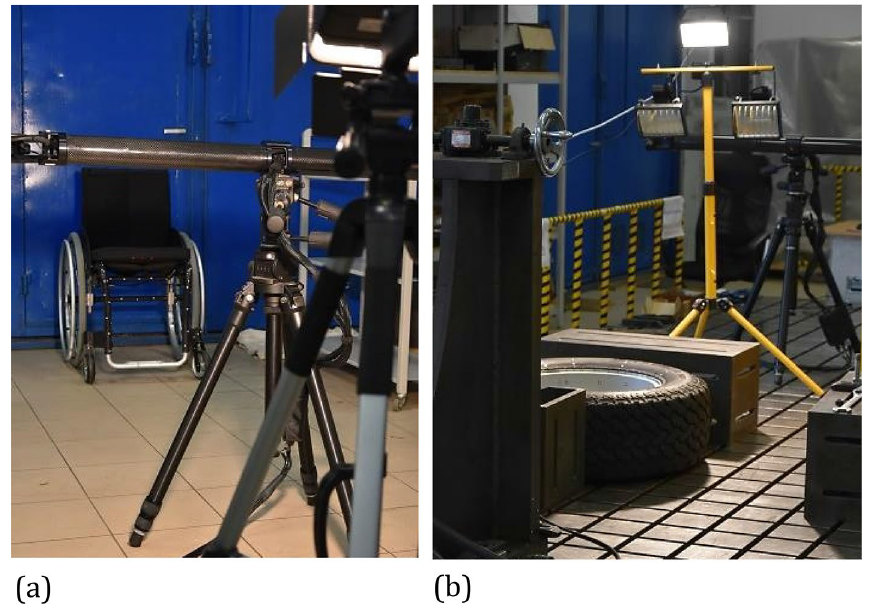
Figure 5. PONTOS 5 M DIC system used in experiments: ( a ) wheelchair; ( b ) SUV